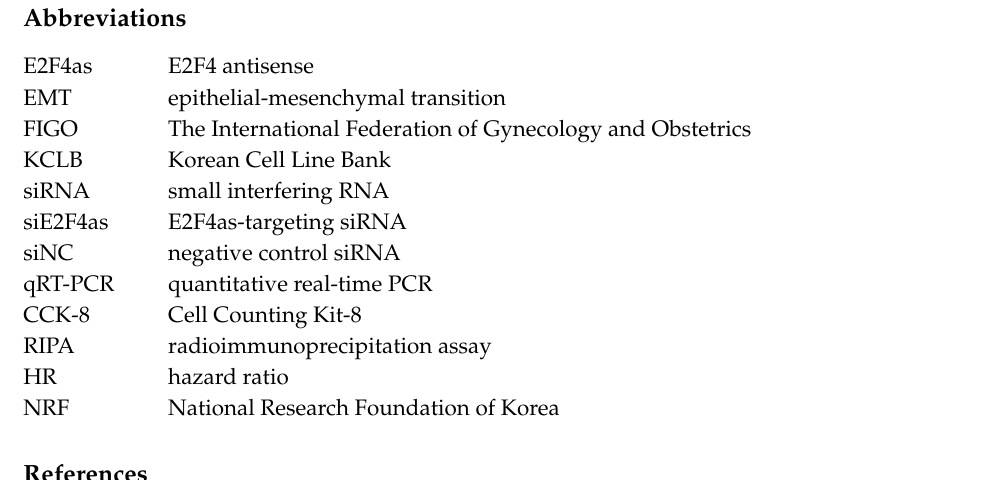
Table S1: Present-study primer sequences of real-time PCR; Table S2: Present-study siRNA primer sequences; Figure S1: Expression of lncRNA E2F4as measured by qRT-PCR and MTT assay in SKOV3 and OVCA429 cell lines of siRNA- E2F4as transfection; Figure S2: The whole western blot for Figure 4; Figure S3: The whole western blot for Figure 5; Figure S4: EMT-associated genes were analysed by qRT-PCR in mouse tumour tissues for Figure